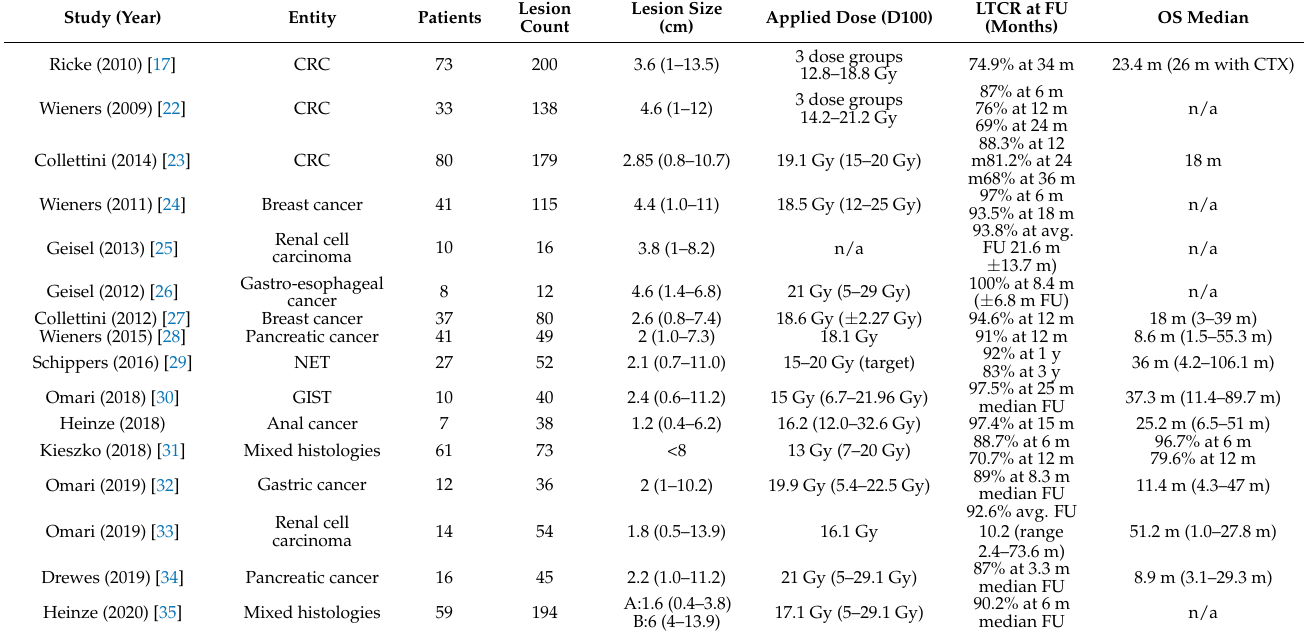
Table 2. Literature review of interstitial-brachytherapy of liver